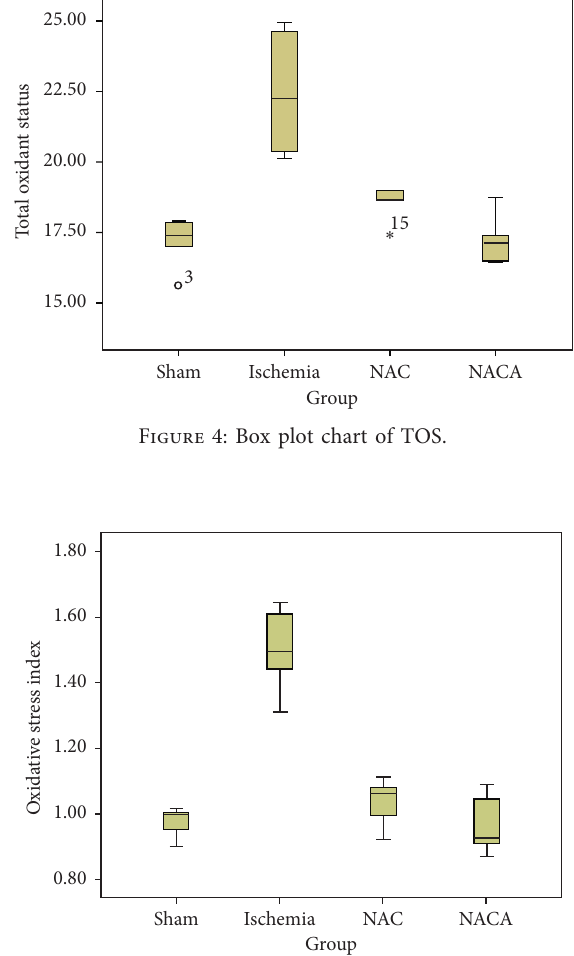
Figure 5: Box plot chart of